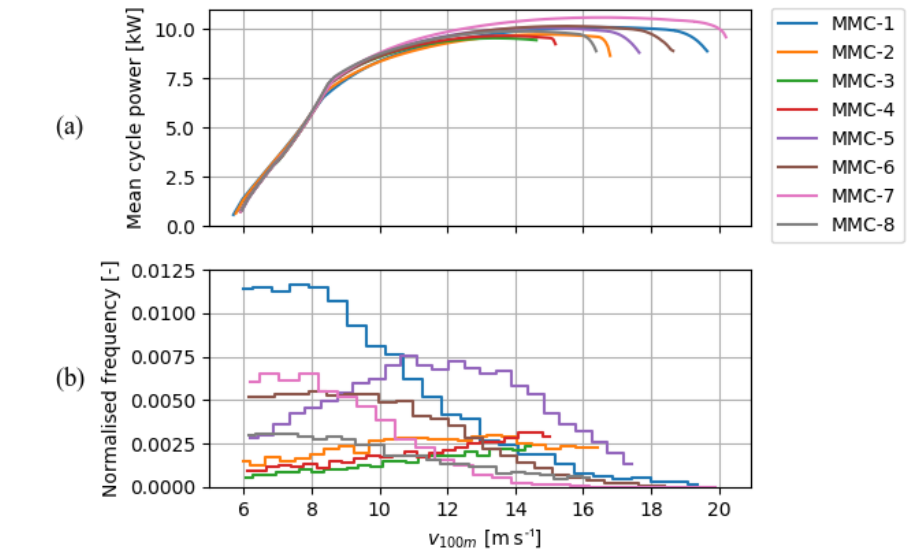
Figure 20. Power curves obtained by performance optimisations using the scaled cluster-mean wind profile shapes of MMC-1–8 (a) . Wind speed distribution of the samples within each cluster using the full onshore dataset (b) . Only the frequencies between cut-in and cut-out are depicted, and every four wind speed bins are aggregated purely for illustrative purposes and shown as a single bin.